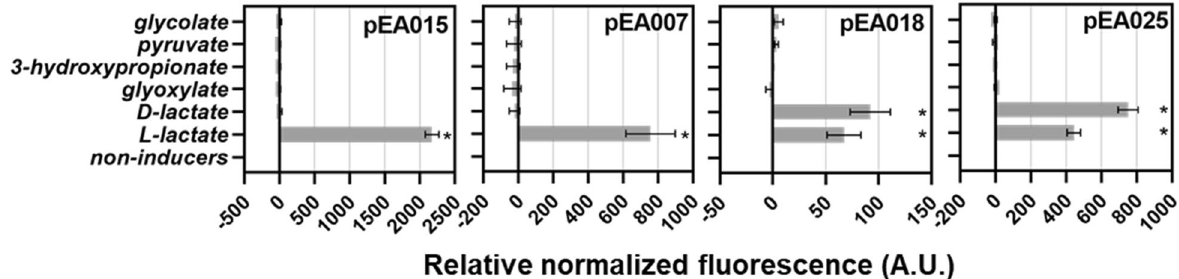
Figure 4. Relative normalized fluorescence of E. coli DH5α, C. necator H16, and P. putida KT2440 harbouring pEA015 with Ec LldR/P lldP , pEA007 with Cn GntR/P H16_RS19190 , pEA018 with Pa PdhR/P lldP , and pEA025 with Pf PdhR/P lldP . Single time-point fluorescence measurements were taken 6 h after addition of different compounds to a final concentration of 5 mM. Error bars represent standard deviations of three biological replicates, * p ≤